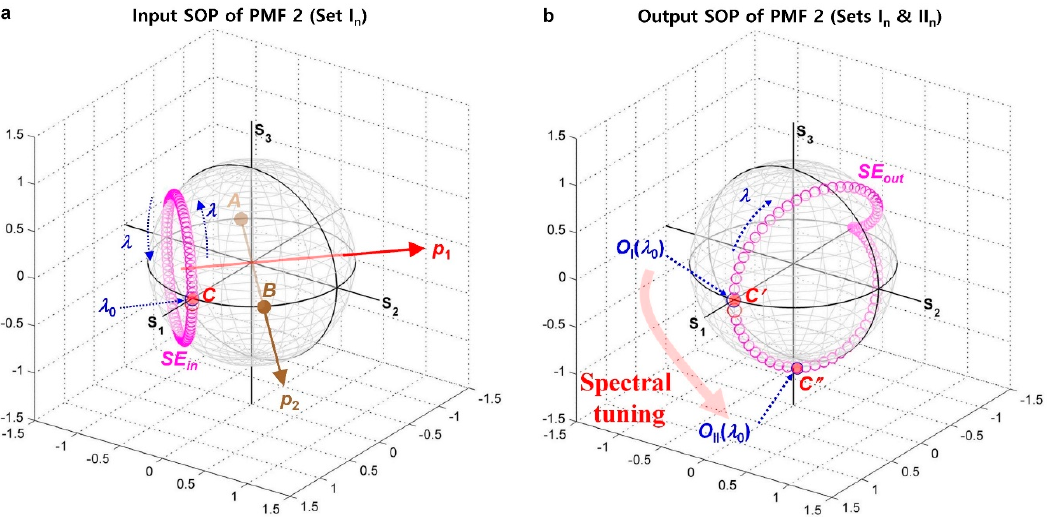
Figure 2. ( a ) Poincare sphere representation of the spectral evolution of SOP in of PMF 2 at Set I n ( ϕ = 0°), which is denoted by SE in (indicated by pink circles) and ( b ) Poincare sphere representation of the spectral evolution of SOP out of PMF 2, which is denoted by SE out (indicated by pink circles), and two O ( λ 0 ) positions at two chosen WOA sets (Sets I n and II n ). All the SOP traces are obtained in the CW path of Figure 1b over a wavelength range from λ 0 to λ 0 + ∆ λ .